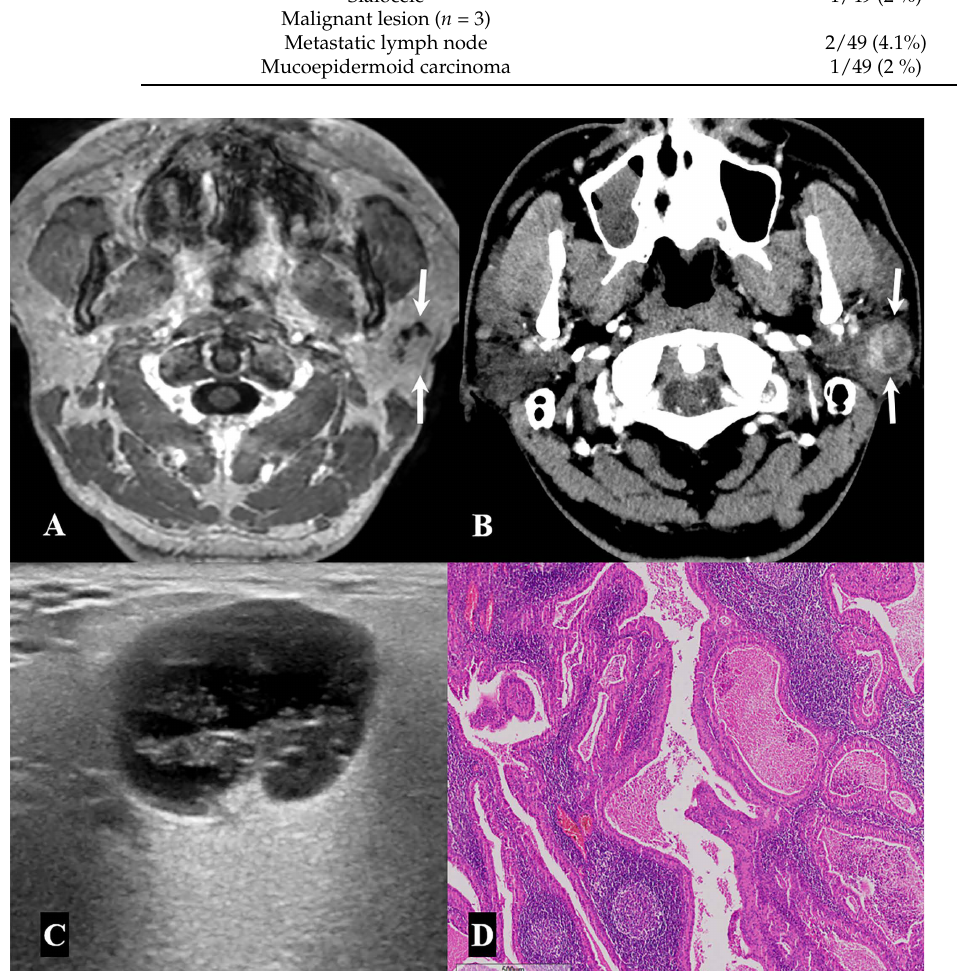
Figure 2. A 48-year-old man with a Warthin tumor. ( A,B ) Contrast-enhanced axial T1-weighted image ( A ) and enhanced axial neck computed tomography (CT) image ( B ) show a well-circumscribed, oval, heterogeneously enhancing mass with intratumoral cystic components in the left parotid gland. ( C ) The mass demonstrates mixed cystic and solid features with posterior acoustic enhancement on neck ultrasonography. ( D ) Histopathological examination of a specimen from the superficial parotidectomy shows double layers of oncocytic tumor cells in the background of dense lymphoid stroma and many germinal centers, suggesting a Warthin tumor ( × 40 magnification; hematoxylin and eosin